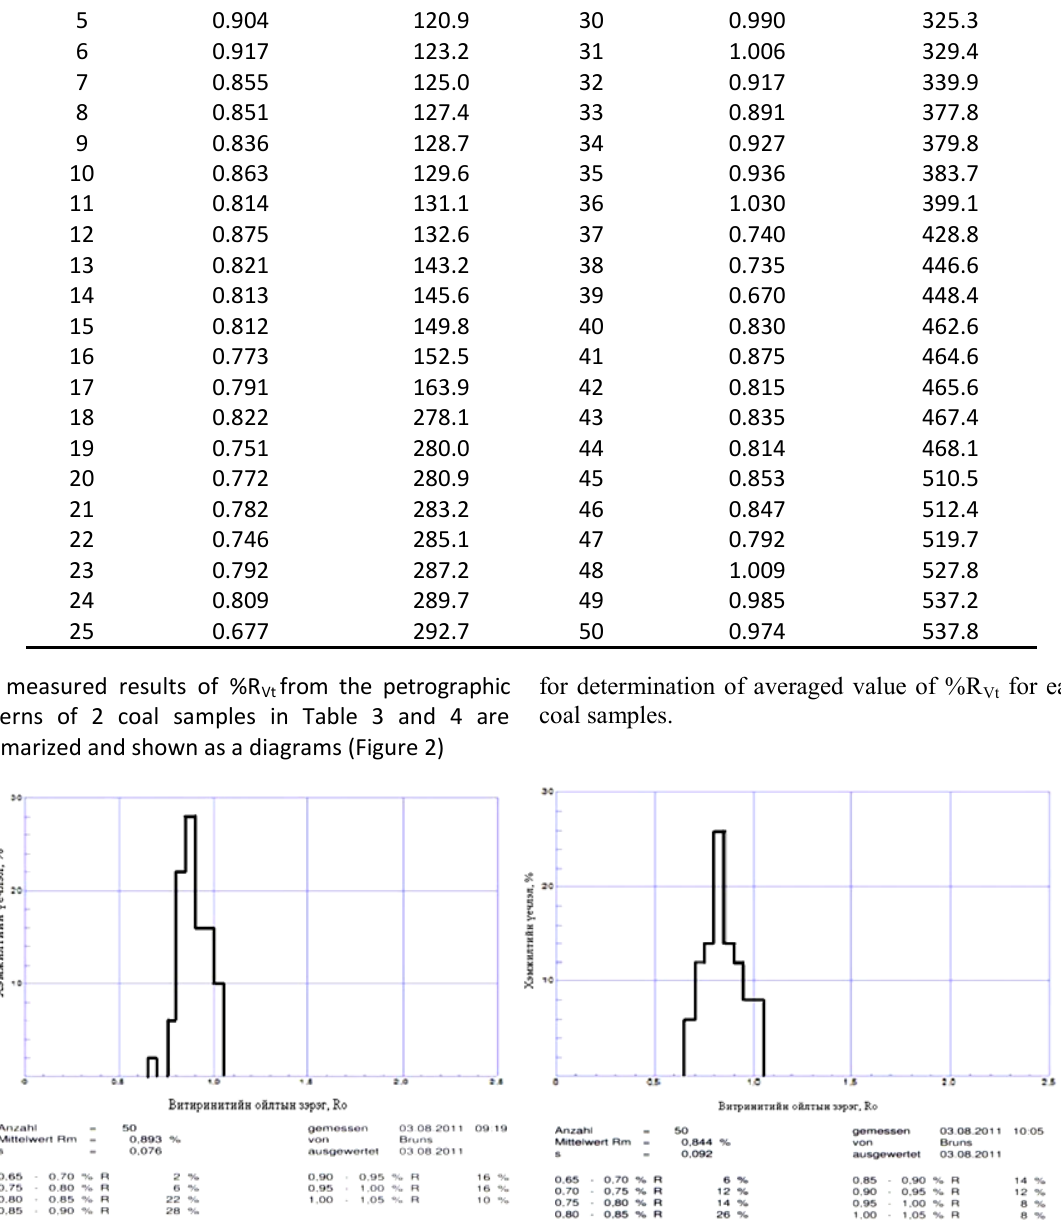
B for coal of Tavan tolgoi deposit: Vt